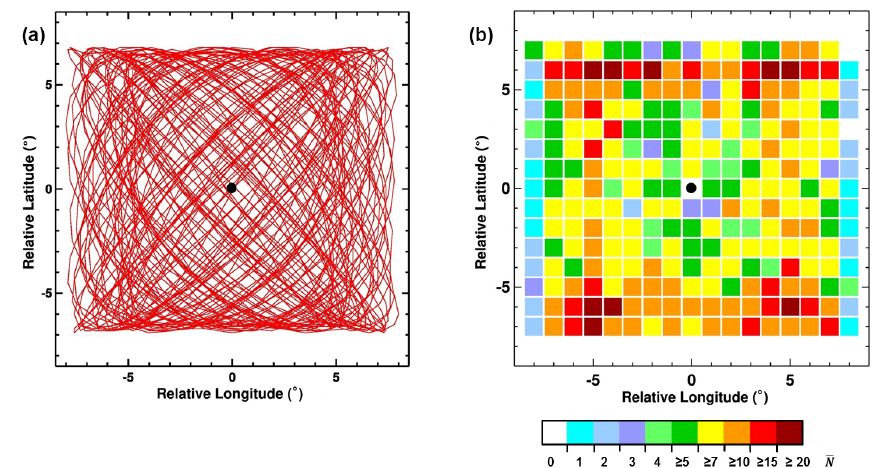
Figure 8. Visual libration of Earth during 2022–2027 (6 years or 2191d): (a) trajectory of the center of the Earth in the sky of the Moon; (b) statistics of the distribution of the 2191 positions of the center of the Earth for 6 years. N is the number of entries of the Earth center into each 1 ◦ × 1 ◦ grid cell for this period (or how many days the Earth spent in a 1 ◦ × 1 ◦